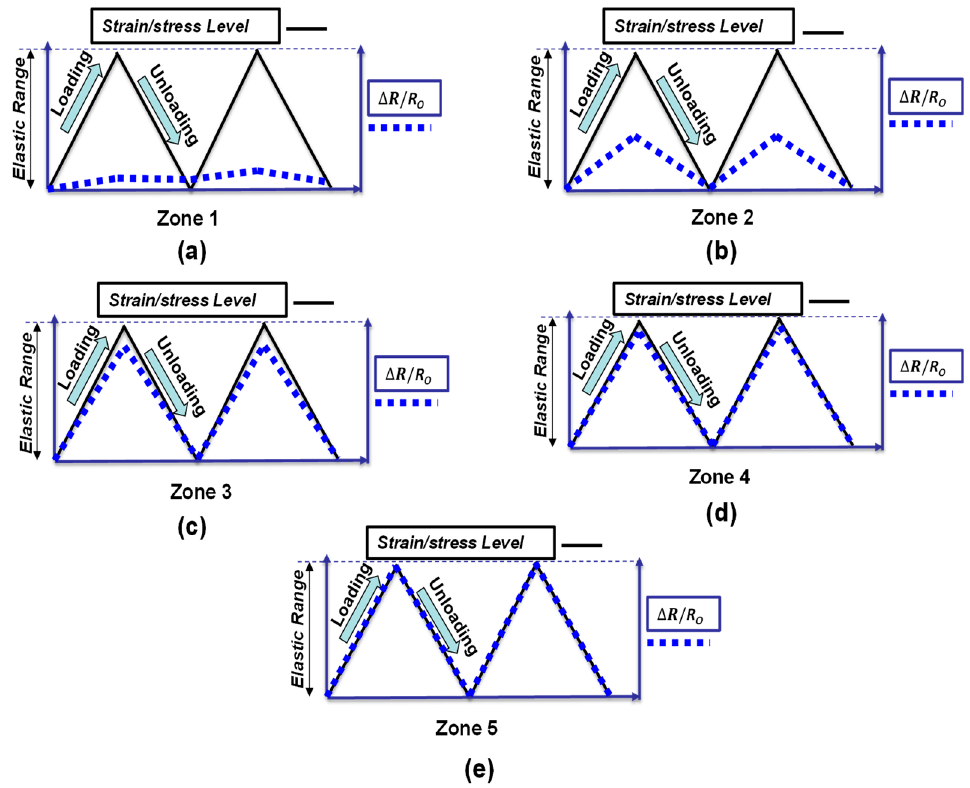
Figure 8. The relationship between the fractional change in resistance and filler concentration under externally compressive loading: ( a ) zone 1; ( b ) zone 2; ( c ) zone 3; ( d ) zone 4; ( e ) zone 5.